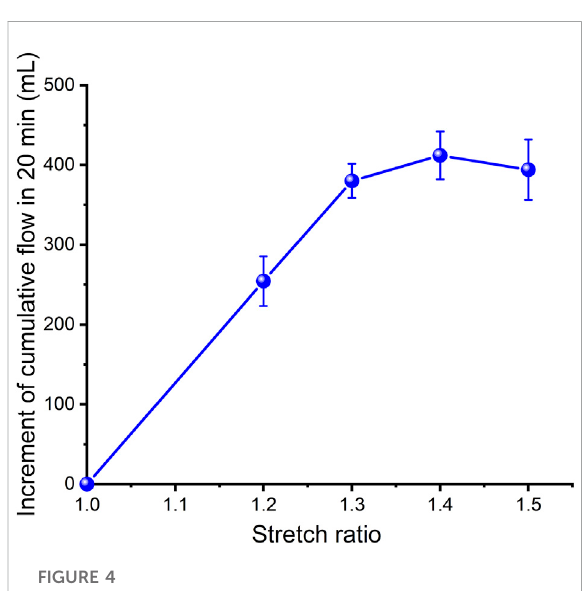
FIGURE 4 Increment in cumulative fl ow over 20 min with different stretch ratios for porcine